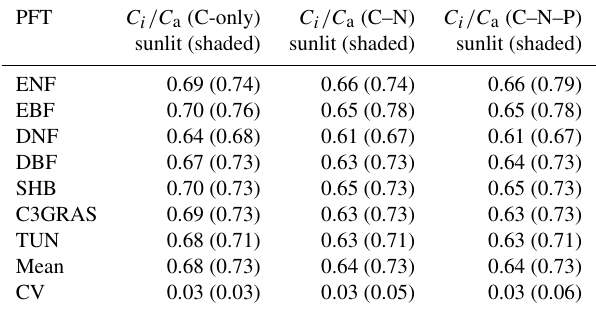
Table 1. The ratio of intercellular CO 2 concentration ( C i ) to atmo- spheric CO 2 concentration ( C a ) for different C 3 PFTs, and mean and coefficient of variation (CV) across these PFTs of C i /C a in C- only, C–N, and C–N–P simulations of CABLE under the RCP 8.5 scenario. Values for shaded leaves are in brackets. Abbreviations are the same as Fig. 1.